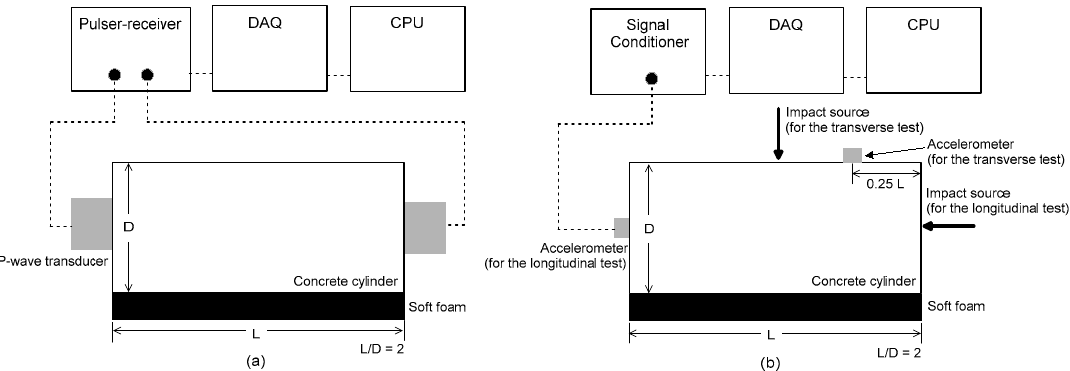
Figure 4. Test setup of evaluating dynamic properties of concrete cylinders for: ( a ) the ultrasonic pulse velocity test and ( b ) the resonance vibration frequency test.